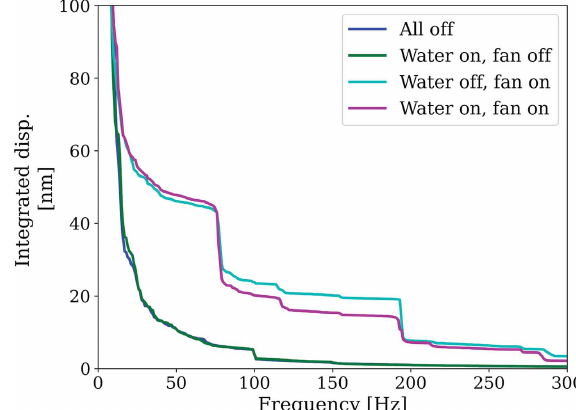
Figure 7 Integrated displacement from accelerometer signals, showing relative contributions of different frequency bands to the total RMS displace- ment.